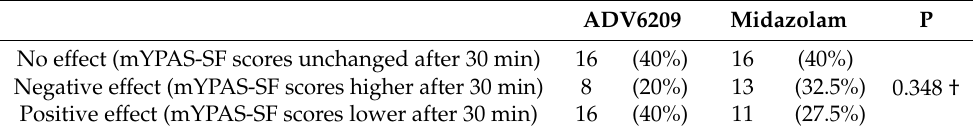
Table 3. Effects on mYPAS-SF* anxiety scores after as compared to before premedication.